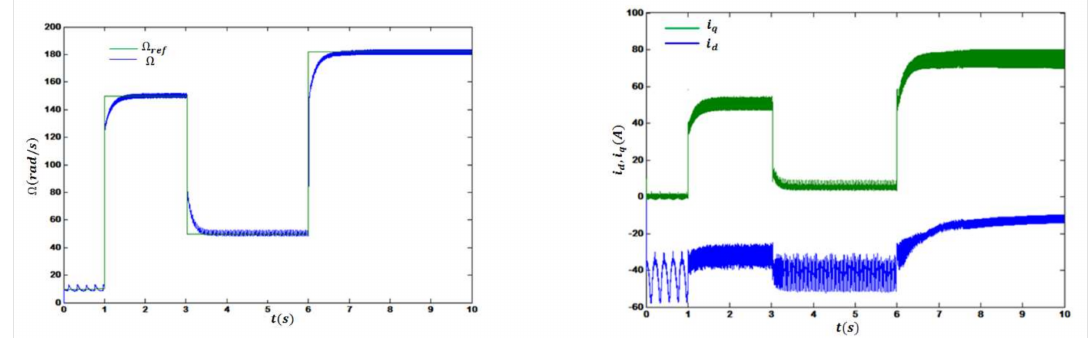
Figure 10. PMSM performance for different reference speed ω ref = 10, 150 and 180 rad / s for the operating point OP 1 , and for T = 25 ◦ C.